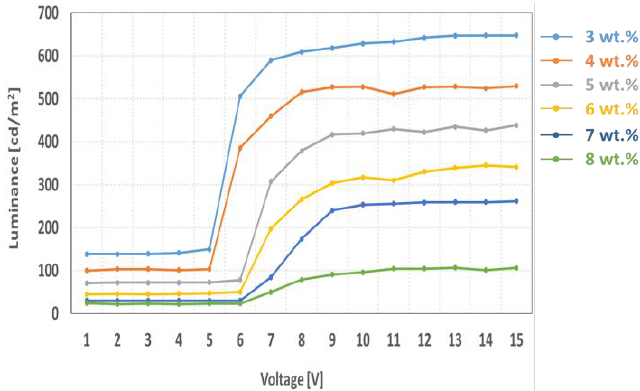
Figure 7. Measured voltage-luminance of the non-polarized mode LC cell as a parameter of the dye